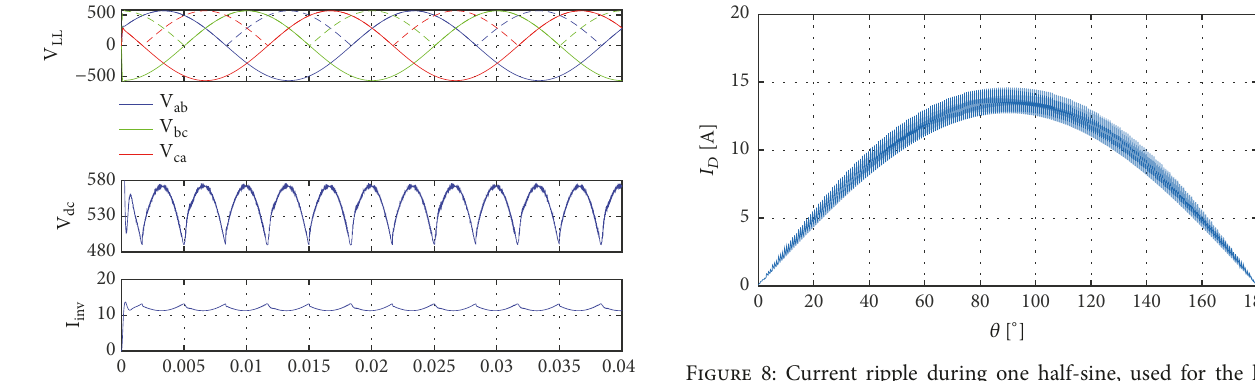
Figure 8: Current ripple during one half-sine, used for the loss switching